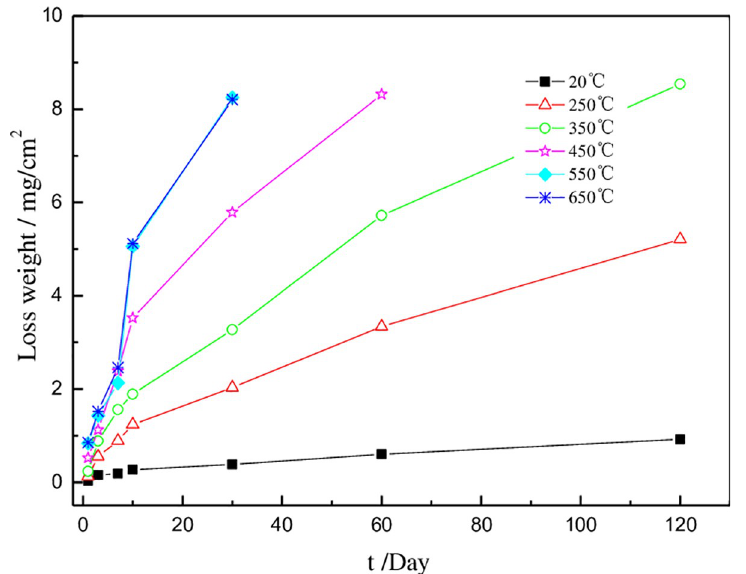
Fig 4. Average weight loss of the coatings in 0.4mol/L